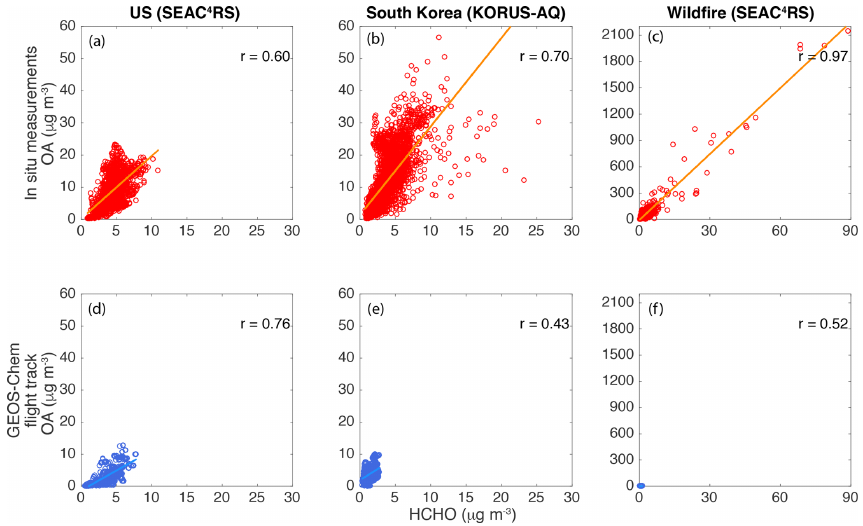
Figure 4. Scatter plots of OA vs. HCHO for the US (SEAC 4 RS altitude <1km non-BB), South Korea (KORUS-AQ altitude <1km), and wildfires (SEAC 4 RS) from in situ measurements (a, b, c) and GEOS-Chem outputs sampled along the flight tracks (d, e, f) .